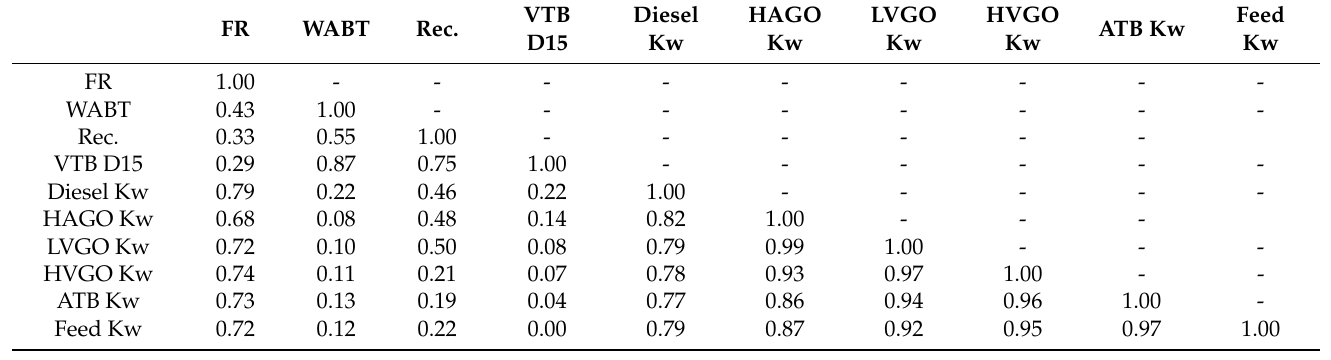
Table 3. Some statistically meaningful relations ( µ -value) between the H-Oil ® feed properties, H-Oil ® operating conditions and H-Oil ® product properties established by the use of Intercriteria analysis.